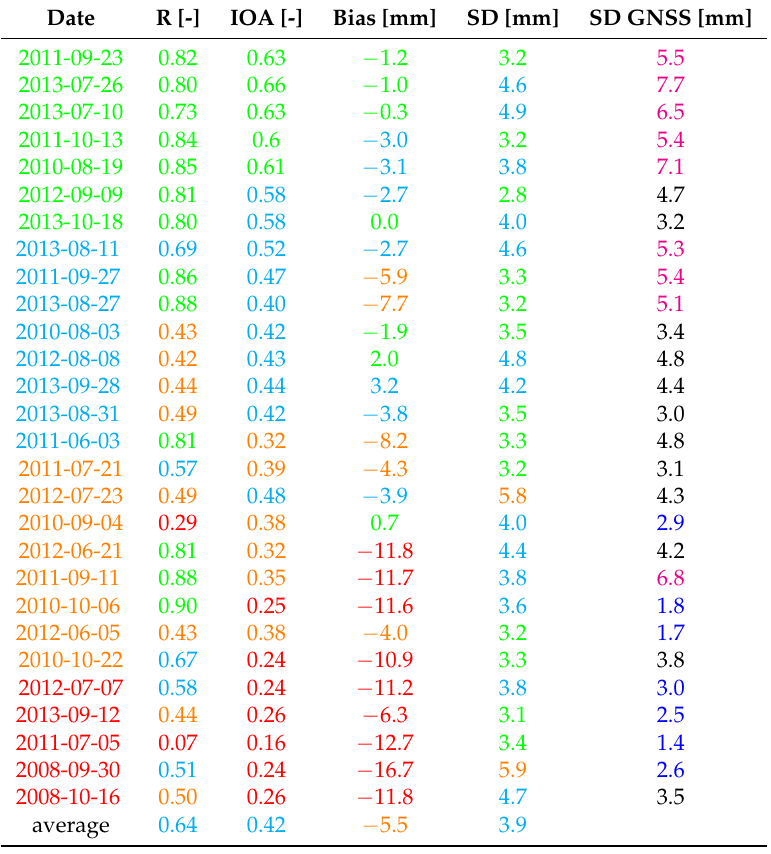
Table 1. The statistics for all acquisitions sorted by the agreement between GNSS and InSAR starting with the best agreement. The colors denote the following: green—good agreement, cyan—moderate agreement, orange—poor agreement and red—very poor agreement. The last column presents the SD of the GNSS estimates only. The colors denote: pink—high variability (>5 mm), navy blue—low variability (<3 mm), black—average variability (between 3 and 5